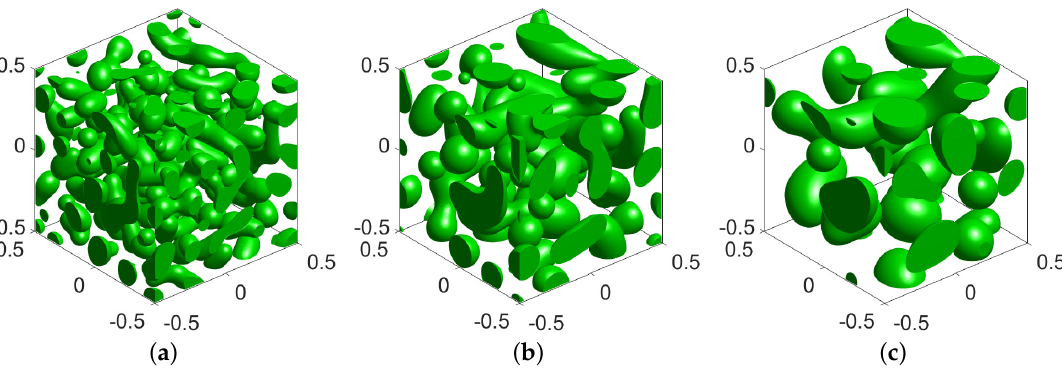
Figure 28. Temporal evolutions of the CH equation with the initial condition (82) using the Fourier-spectral method. ( a – c ) are the snapshots of zero level set to the numerical solutions at t = 500 ∆ t , 1500 ∆ t , and 3000 ∆ t with ∆ t = 0.0001,